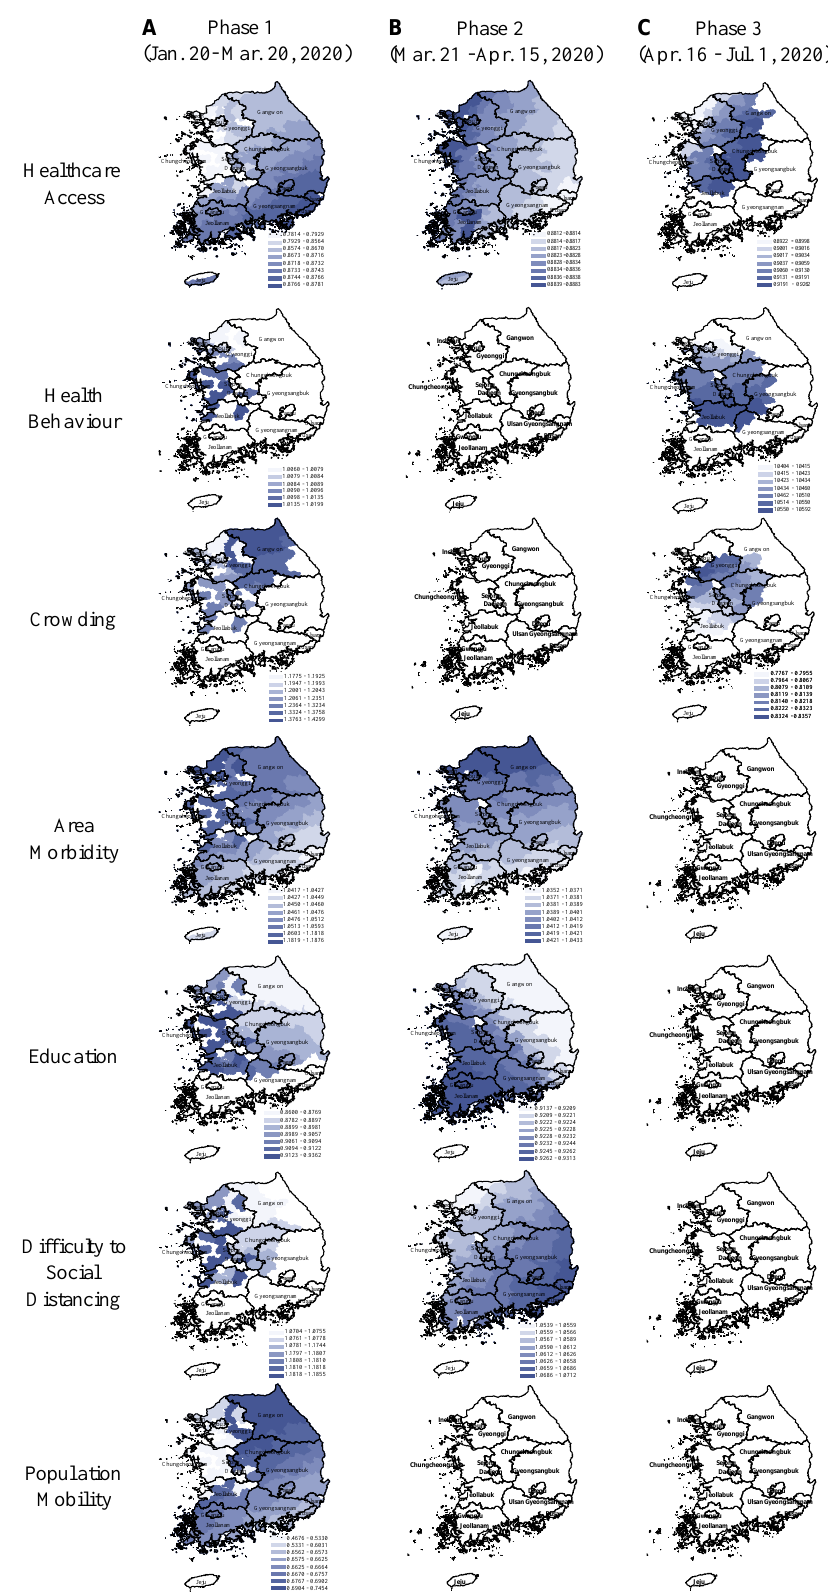
Figure 4. Spatial variation in the relative risk of COVID-19 associated with area-health and SES themes in the early, middle, and late phases of the pandemic (GWNBR models). In the maps, the blue colour gradient corresponds with larger (darker) to lower (lighter) relative risk. Areas in white indicate the relative risks are statistically not significant ( α = 0.05). The figure consists of ( A – C ) columns respectively referring to the pandemic’s early (20 January to 20 March 2020), middle (21 March